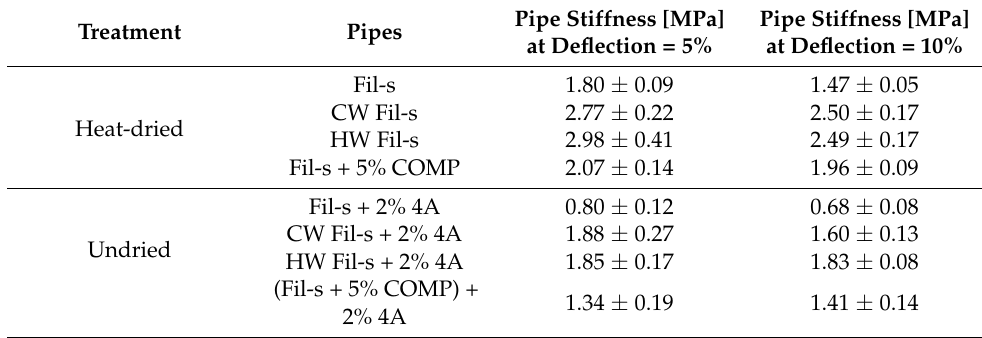
Table 5. Pipe stiffness values of heat-dried and not-dehumidified Fil-s based systems.